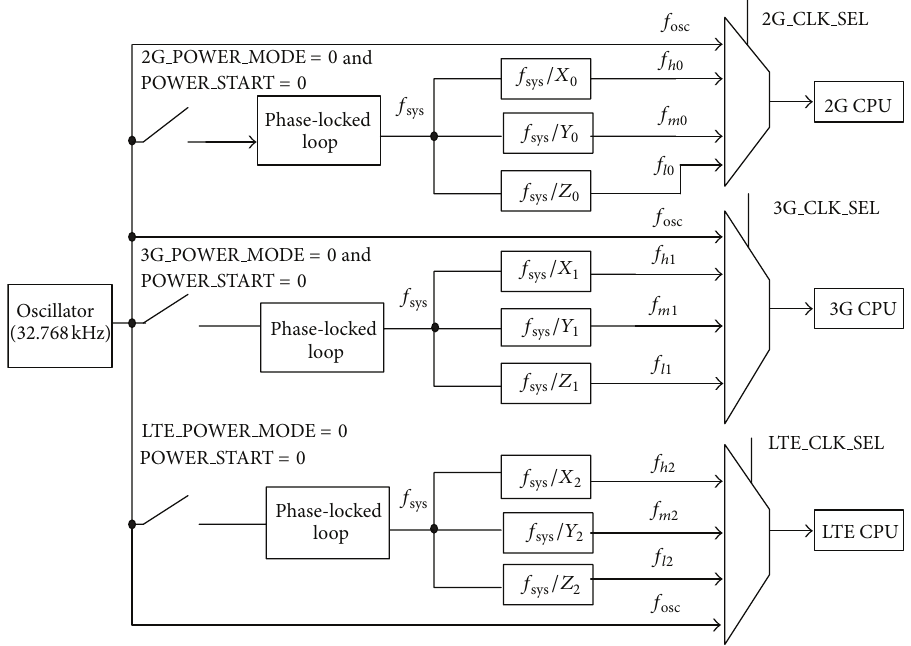
Figure 2: The clock